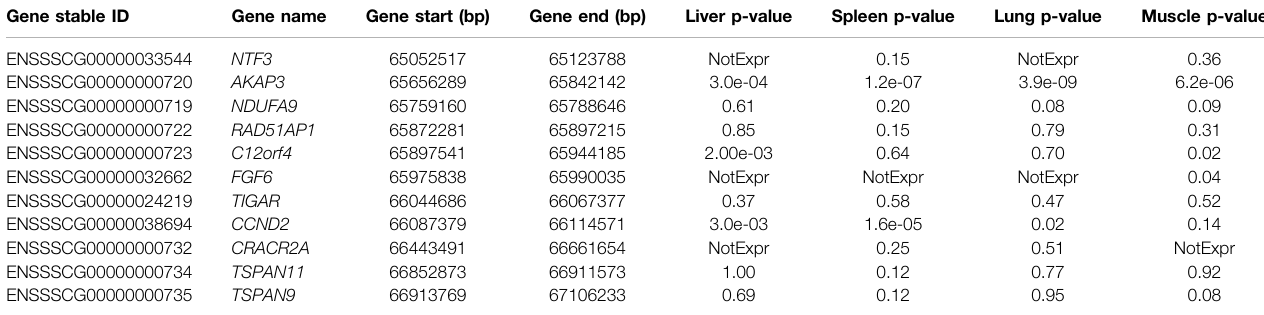
TABLE 10 | Expression and eQTL results in the SSC5 backfat locus (5:65-67 Mb). Gene stable ID